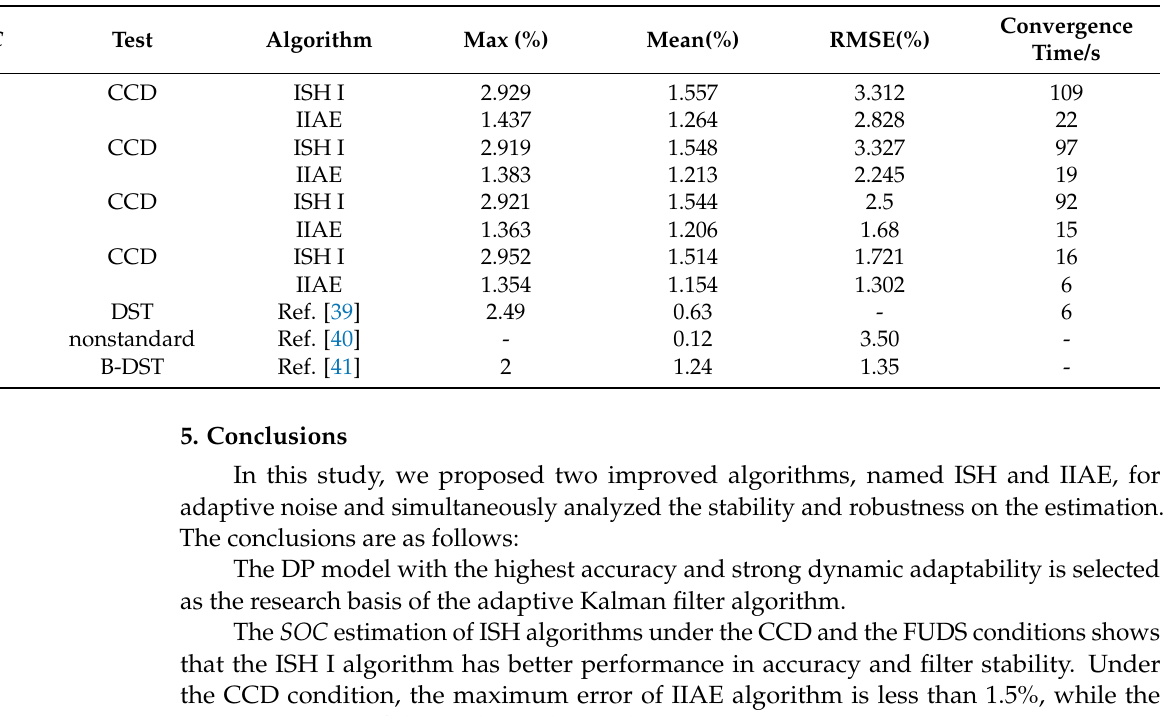
Table 5. SOC estimation errors analysis at different initial values of SOC